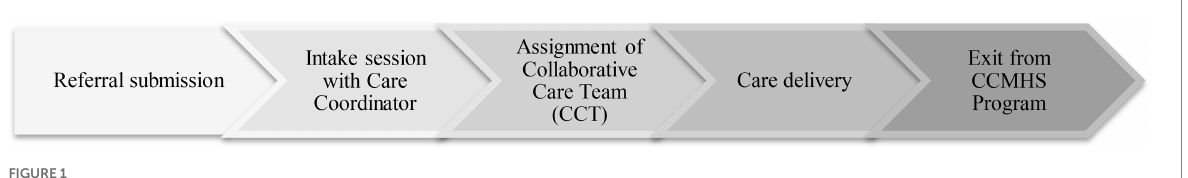
FIGURE 1 CCMHS mental health care